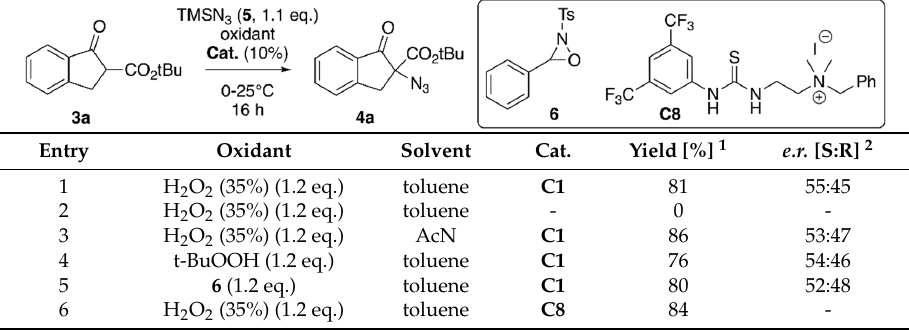
Molecules 2018 , 23 , x FOR PEER REVIEW